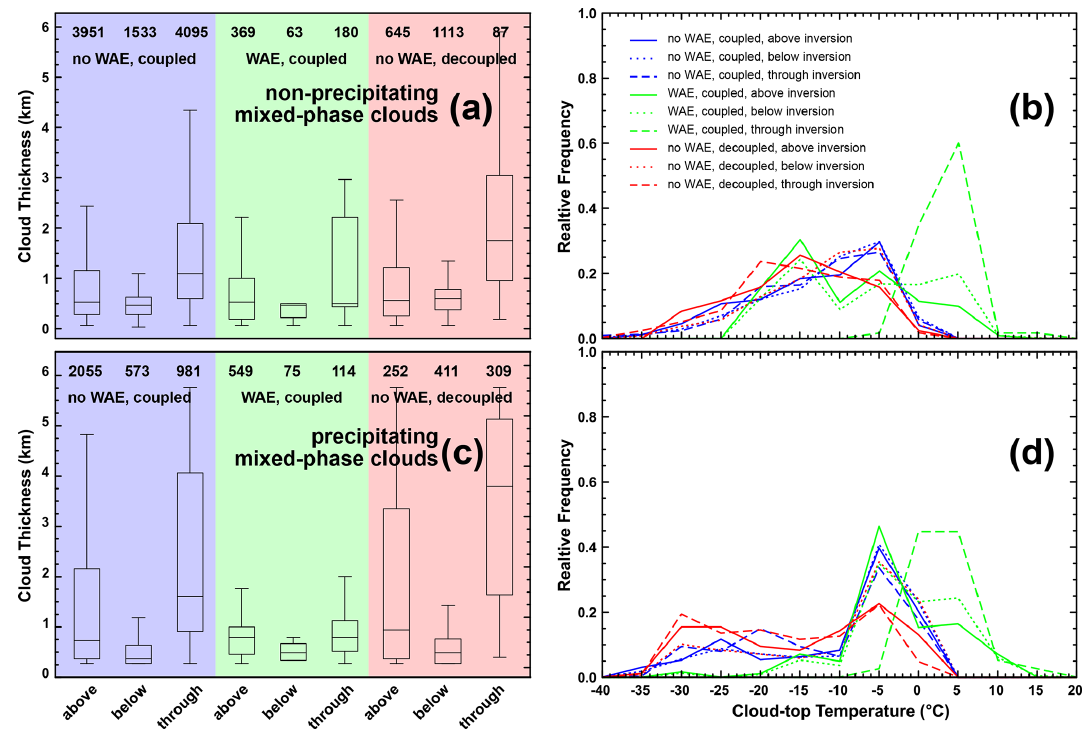
Figure 10. Same as Fig. 9 but for non-precipitating (a, b) and precipitating (c, d) mixed-phase